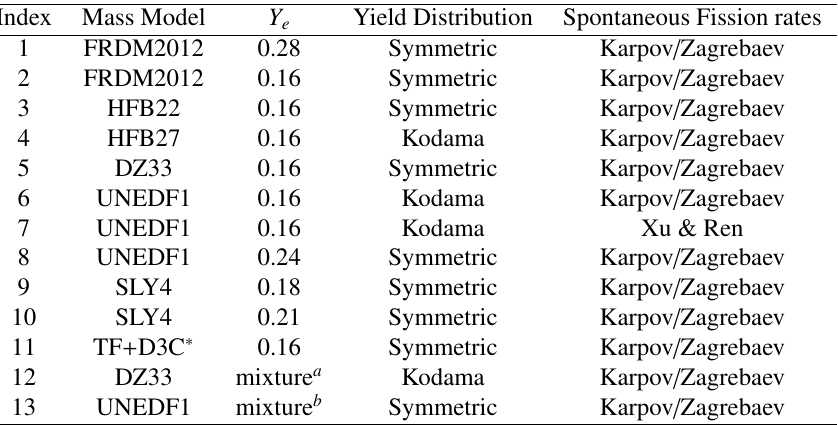
Table 1. Highlighted Simulations Setup (for details see